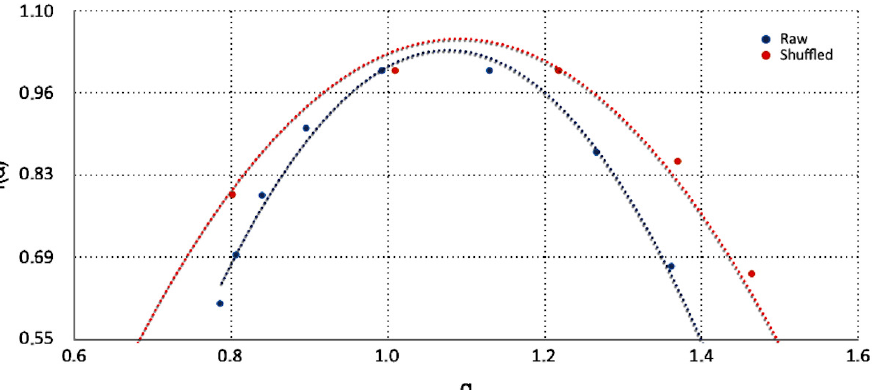
Figure 5. Multifractal plot of f ( α ) versus α for the THR monitoring station and date 4 April 2009 (case i/i = 10 of Table 2). Blue dots indicate the raw two-month series and the red dots the shuffled series. The dotted trendlines refer to fitted polynomial curves of order 2. For details, the reader should refer in-text.